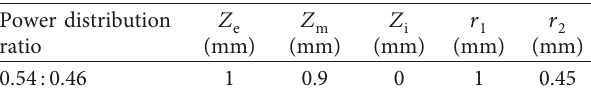
Figure 6: Weld profile for different laser speeds. (6) 2m/min; (7) 1.6 m/min; (8) 1.2m/min; (9) 0.8m/min; (10) 0.4m/min. Table 4: Parameters of the combination heat source mode of cylindrical and cylindrical.